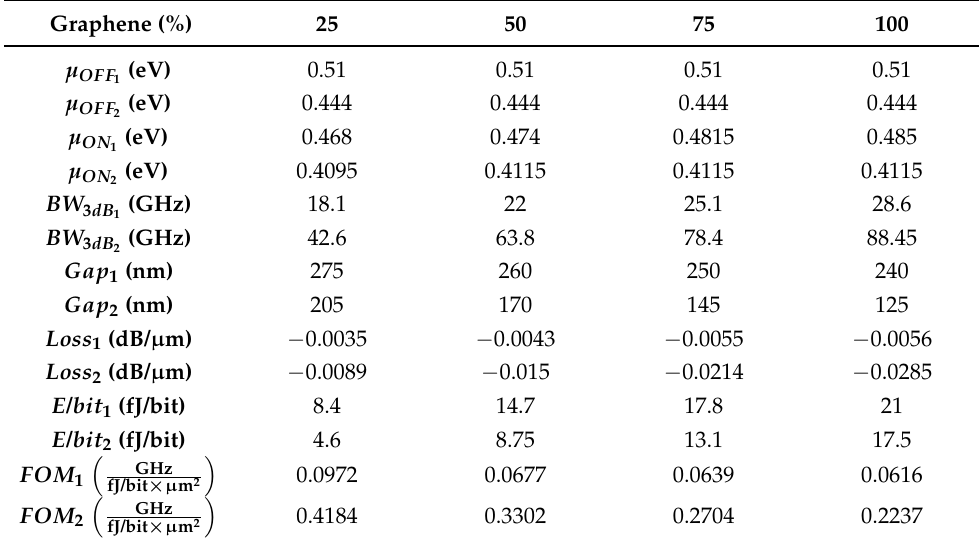
Table 1. Optimization of the modulator’s design and performance